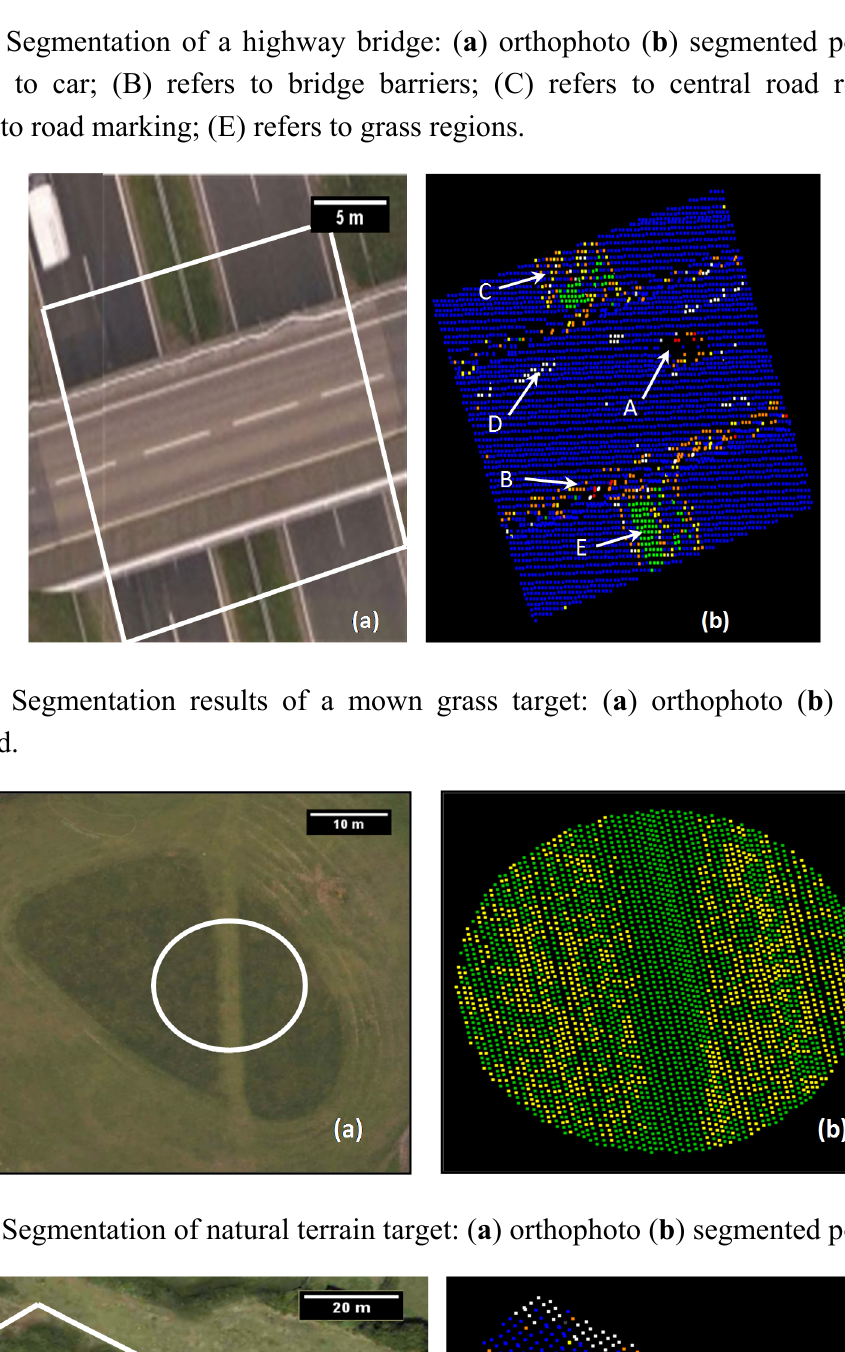
Figure 4. Segmentation of a highway bridge: ( a ) orthophoto ( b ) segmented point cloud.